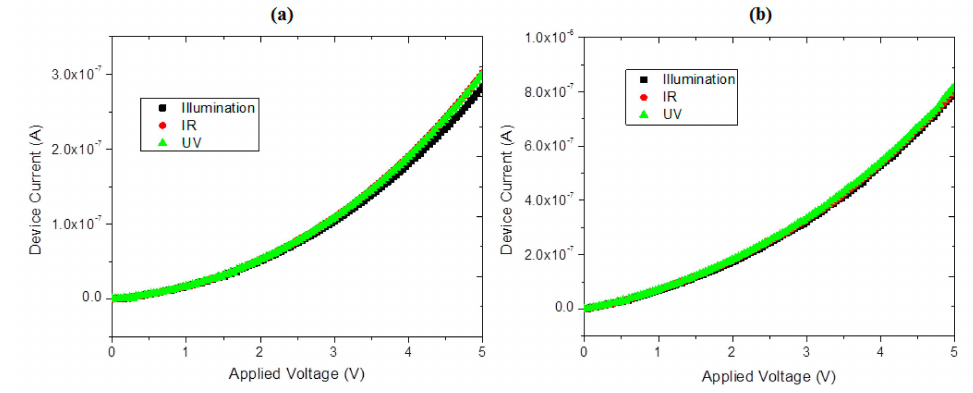
Figure 6. Current-voltage characteristics of the glass/ITO/TTF deriv -CuPc/Al device (in air) under white, infrared and UV illumination: ( a ) ITO is positively biased and ( b ) ITO is negatively biased.